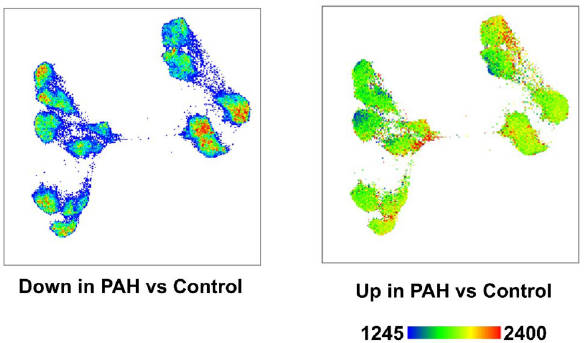
Figure 4. Distribution of the 629 differentially expressed genes across clusters. TriMap space showing genes down (left figure) and up (right figure) regulated in PAH. The differentially expressed genes did not localize in a single cluster, but were spread across all